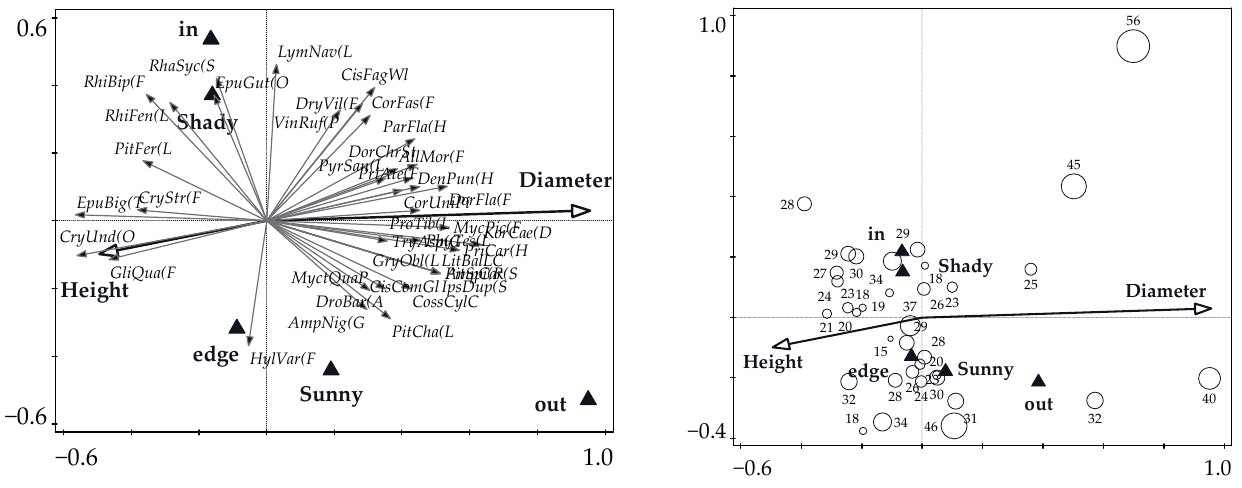
Figure 8. Both diagrams: relationship between species preferences and species richness by samples (the size of each circle indicates the species richness of the samples—absolute number of species in the trap) for heritage tree variables by RDA (pF = 1.4; p = 0.040). Explained by axes; axis 1—8.85%; axis 2—4.43%). Solid symbols are categorical variables and arrows of DBH and height are continu- ous variables.